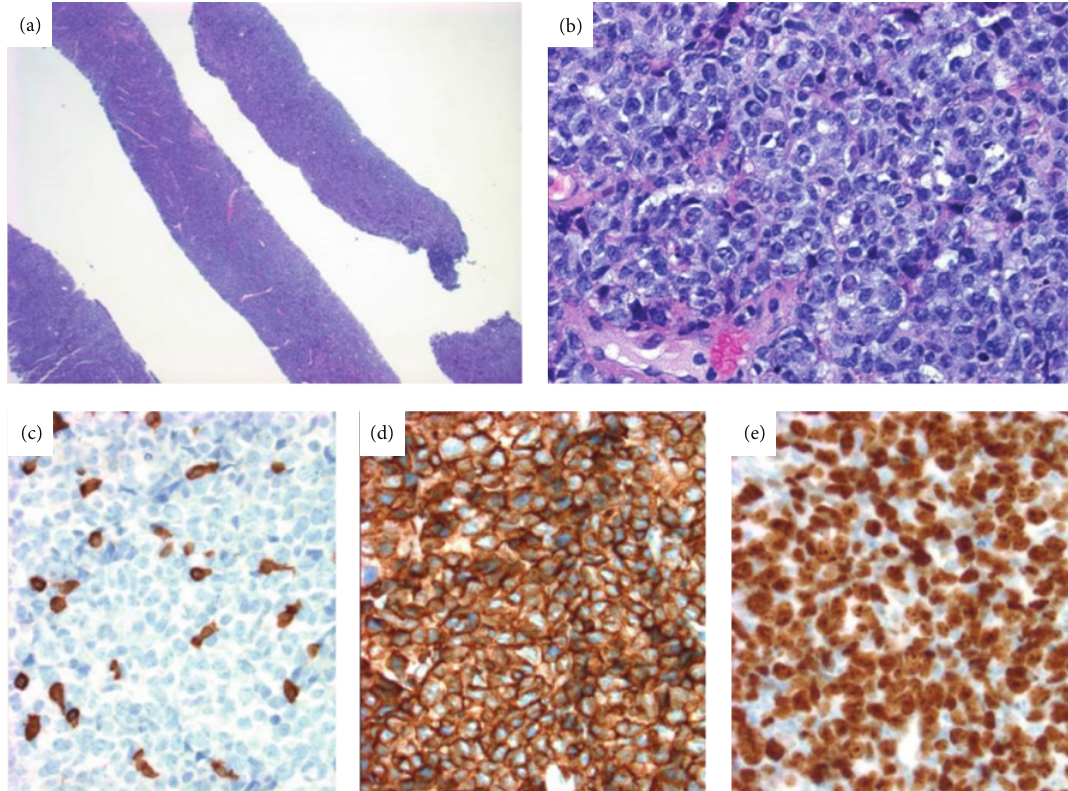
Figure 3: Ultrasound guided core biopsy. (a) Hematoxylin and eosin-stained section shows core needle core biopsy with dense infiltrate of atypical lymphocytes with no residual normal breast tissue being identified (20x). (b) High magnification to demonstrate sheets of large transformed cells with round to irregular nuclei, dispersed chromatin, and prominent nucleoli (400x). Immunohistochemistry stains for (c) CD3; (d) CD20; (e)